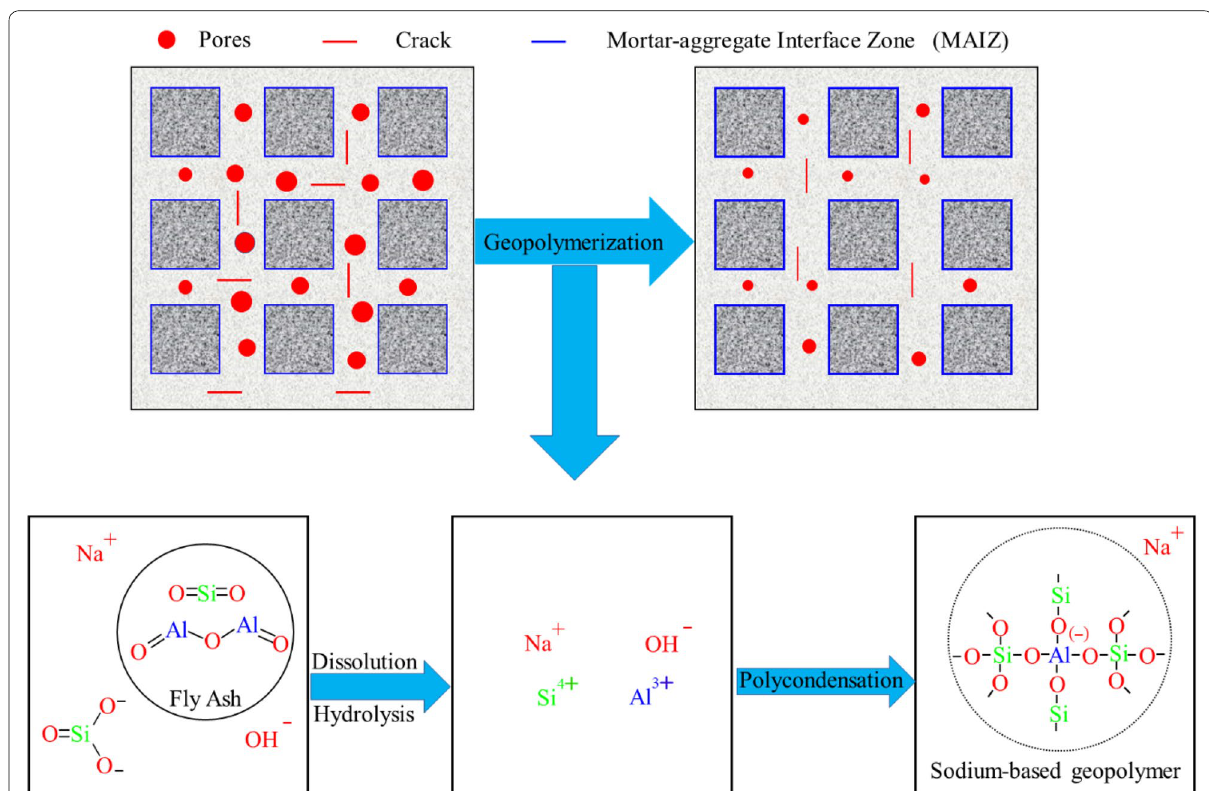
Fig. 12 The schematic diagram of geopolymerization and development in